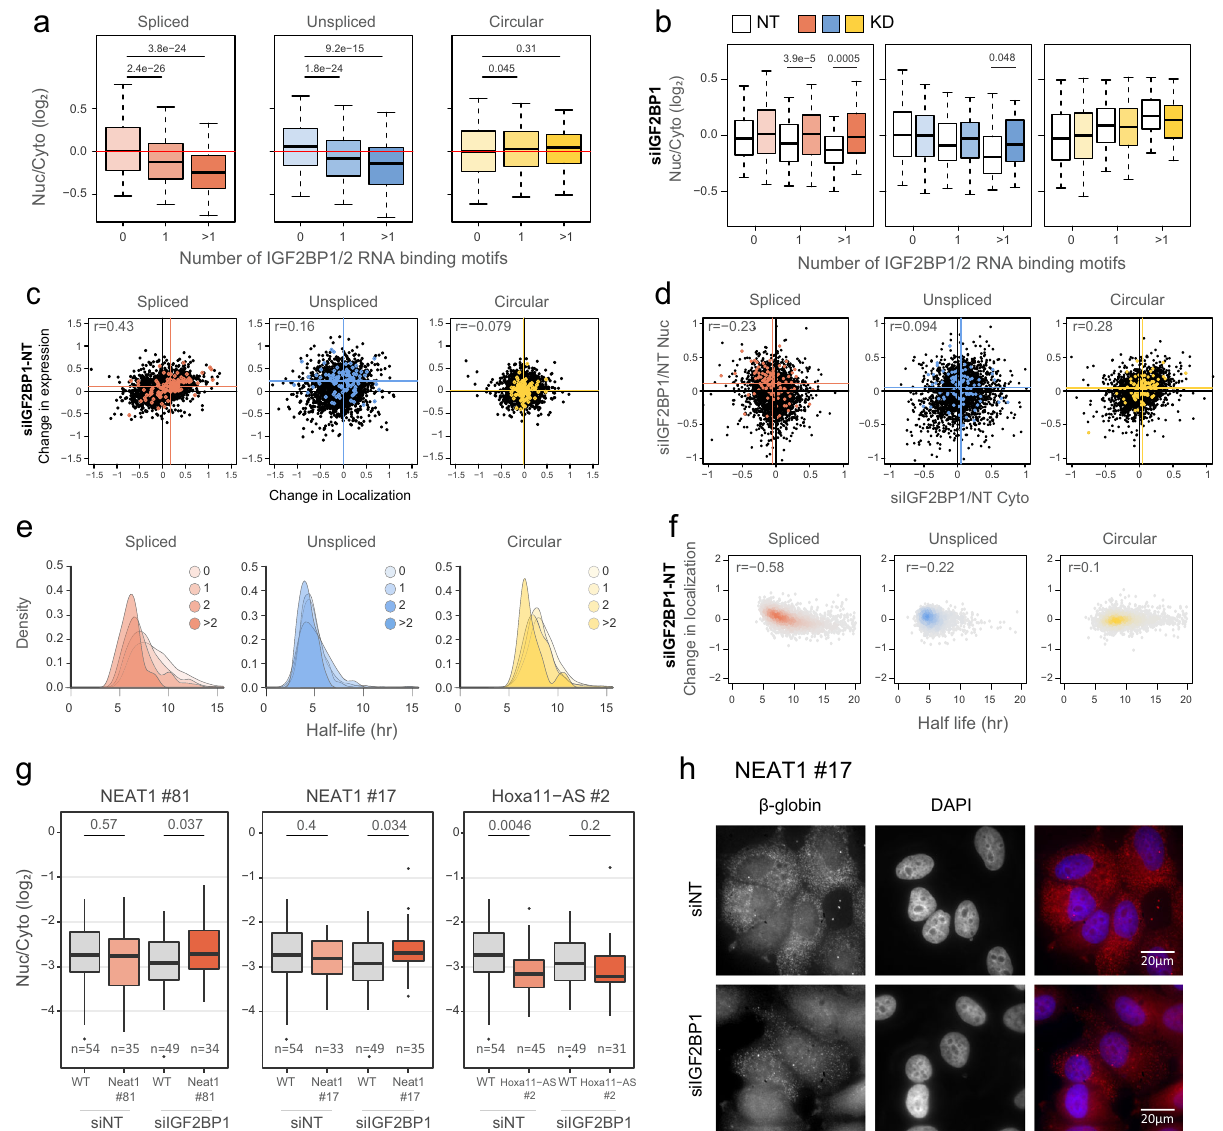
Fig. 5 IGF2BP1 regulates nuclear export of linear spliced RNAs. a Nuc/Cyto ratios of tiles with the indicated number of IGF2BP1/2 motifs in each context; spliced (red), unspliced (blue), and circular (yellow). n = 3 biologically independent samples. Box plots show median, fi rst to third quartile, whiskers are 1.5× interquartile range. P -values were computed using two-sided Wilcoxon rank-sum test. b Nuc/Cyto ratio of tiles with the indicated number of IGF2BP1/ 2 motifs following transfection of NT control (white) and siIGF2BP1 (colored). n = 3 biologically independent samples. Box plots are as in ( a ). P -values were computed using two-sided Wilcoxon rank-sum test. c Correlation between the change in localization (X axis, normalized log 2 (Nuc/Cyto) values in KDs samples vs. control) and expression (Y axis, normalized WCE/input values in KDs samples vs. control) of all tiles (black) and tiles that have more than 1 eCLIP cluster (colored) upon depletion of IGF2BP1. Lines indicate X = 0 and Y = 0 (Black) and mean of all tiles that have an IGF2BP1 eCLIP cluster (colored). d Correlation between the change in expression in the cytoplasmic fraction (X axis, normalized values in KDs samples vs. control) and in the nuclear fraction (Y axis, normalized values in KDs samples vs. control) of all tiles (black) and tiles that have an IGF2BP1 eCLIP cluster (colored). Lines indicate X = 0 and Y = 0 (Black) and mean of all tiles that have an IGF2BP1 eCLIP cluster (colored). e Half-life distributions of tiles with the indicated number of IGF2BP motifs in each context. f The correlation between the change in localization (normalized log 2 (Nuc/Cyto) values in KDs samples vs. control) and half-life of tiles in each context. g Quanti fi cation of Nuc/Cyto ratios of β -globin signal as measured by smFISH of the inserted tiles relative to the WT β -globin sequence. n ≥ 31 cells examined over 1 experiment. Box plots are as in ( a ). h Representative smFISH images of β -globin-NEAT1#17 (red) and DAPI (blue) in control and IGF2BP1-depleted cells. Source data are provided as a Source data fi